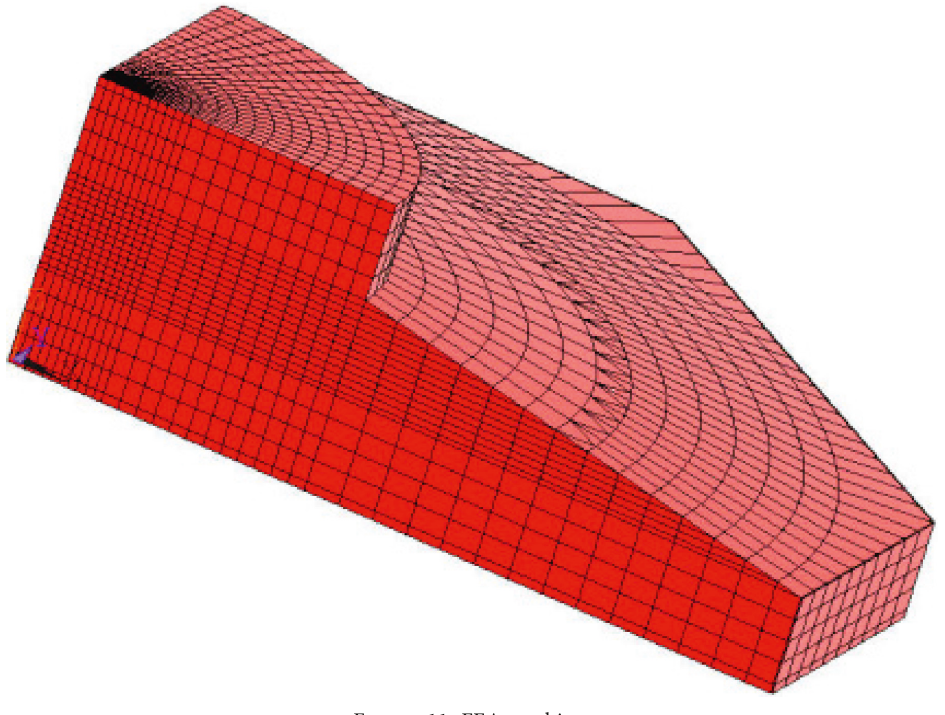
Figure 11: FEA meshing.